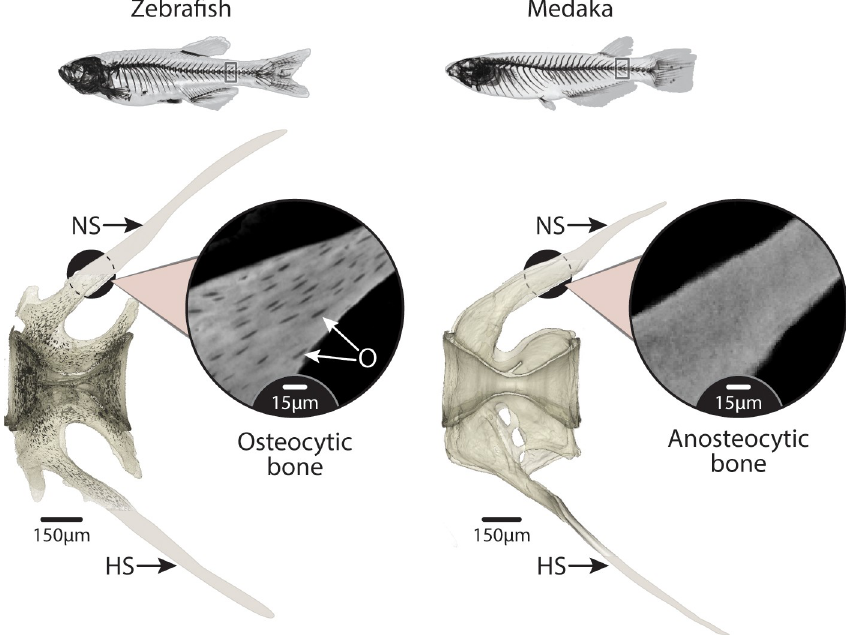
Fig 1. Anosteocytic vertebra of medaka and osteocytic vertebra of zebrafish. High-resolution tomography of caudal vertebrae of zebrafish (left) and medaka (right). O, colored in black in the zebrafish scan, show the ubiquity of cells residing in the bone material of zebrafish while being completely absent from medaka bone material. Note that the distal parts of the NS and HS were cropped in the original scans and are only drawn here for reference; therefore, these parts do not contain lacunae in the zebrafish rendering. Inset images show unsegmented tomography slices at a higher magnification. The vertebrae of both species are hourglass shaped along the cranio–caudal axis (see 3D representation in Fig 3A), with NS and HS extending caudally from the vertebral body. HS, hemal spine; NS, neural spine; O, osteocytic